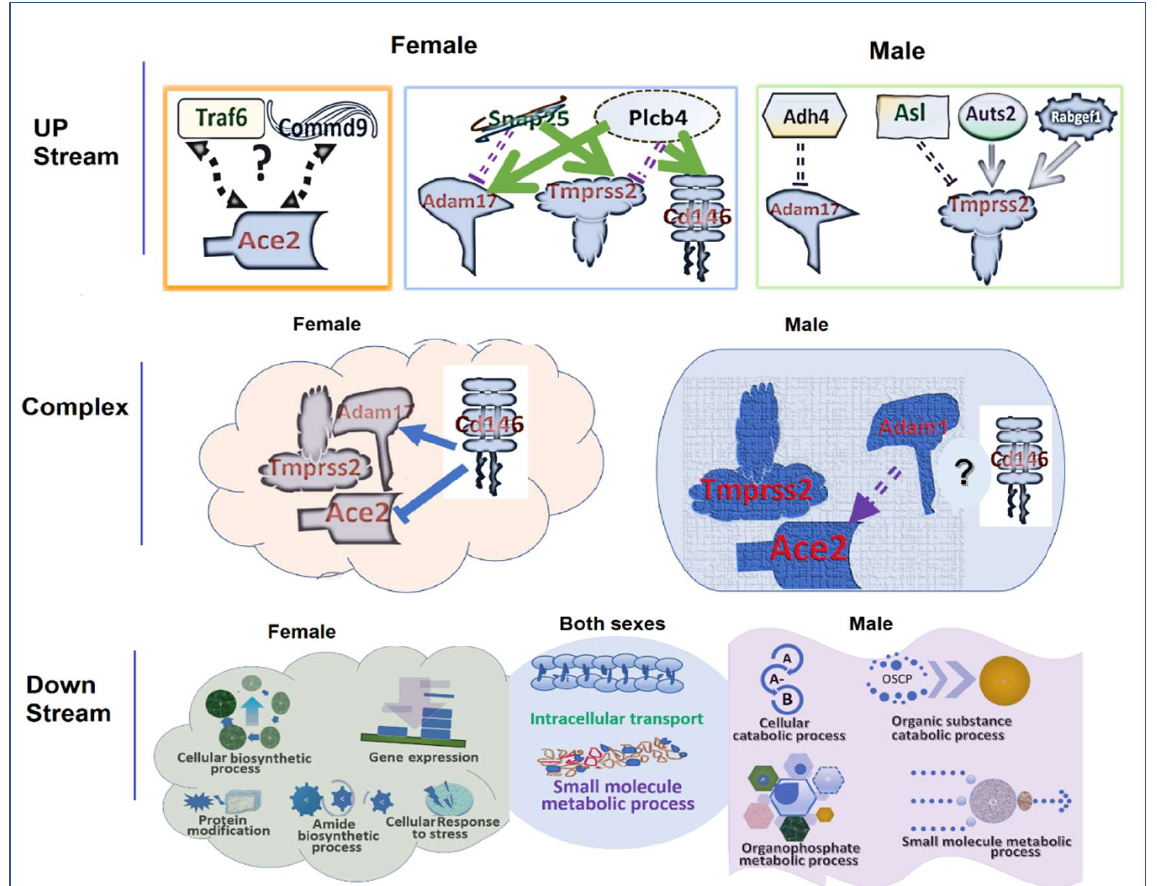
Figure 6. Sex different regulation processes in the Ace2 / Adam17 / Tmprss2 pathways. The process was divided into three stages, the upstream regulation, interplays within the complex, and Ace2 trigged downstream processes. Arrow ended lines are positive regulations of a genes and/or protein to the other while the T ended lines indicate a negative regulation. Solid lines indicate known reaction while dashed lines indicate proposed reactions. Molecules tiered together indicate they are binding together.